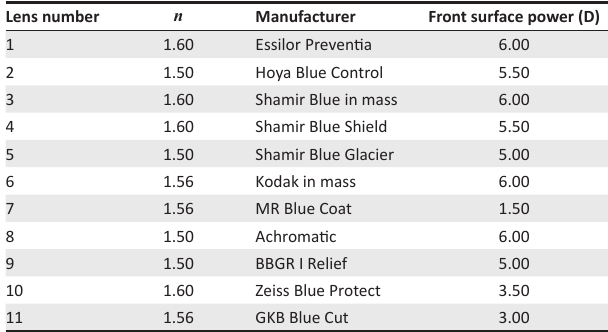
TABLE 1: Lens parameters ( n is refractive index). Lens 8, the achromatic lens, was used as a control lens. Lens